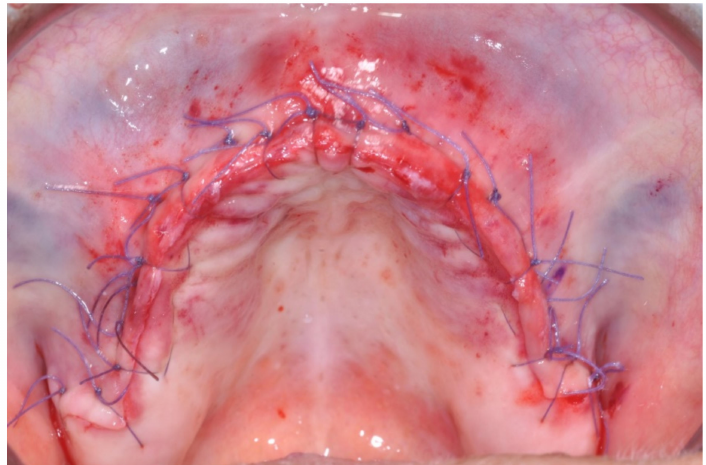
Figure 15. Post-operative view of the patient who developed a minor complication.